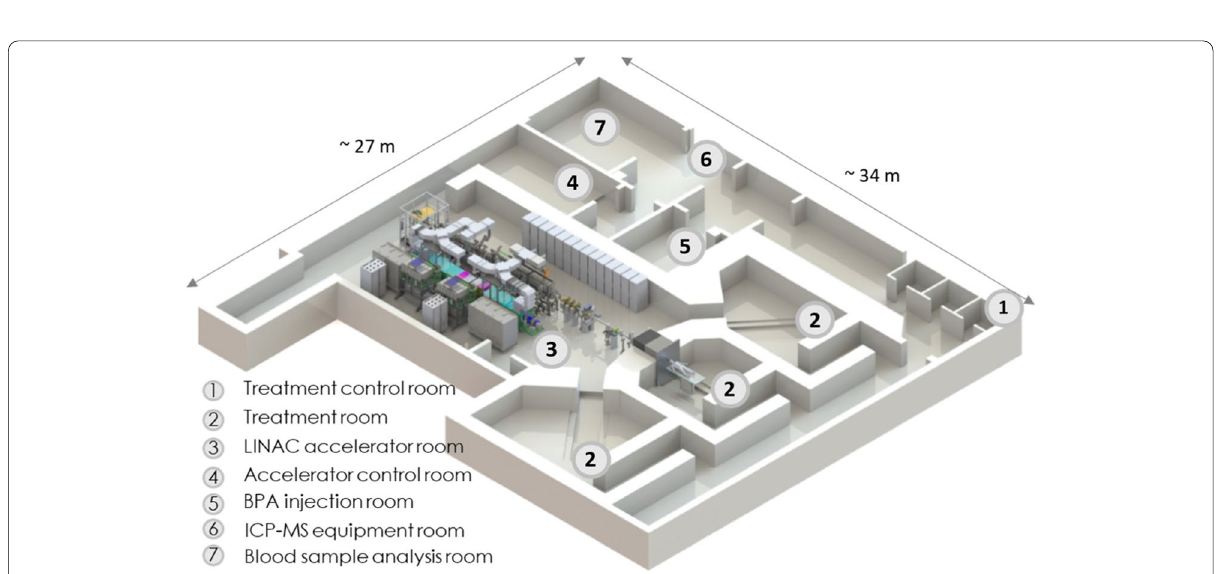
Fig. 7 Layout of the DawonMedax accelerator‑based BNCT